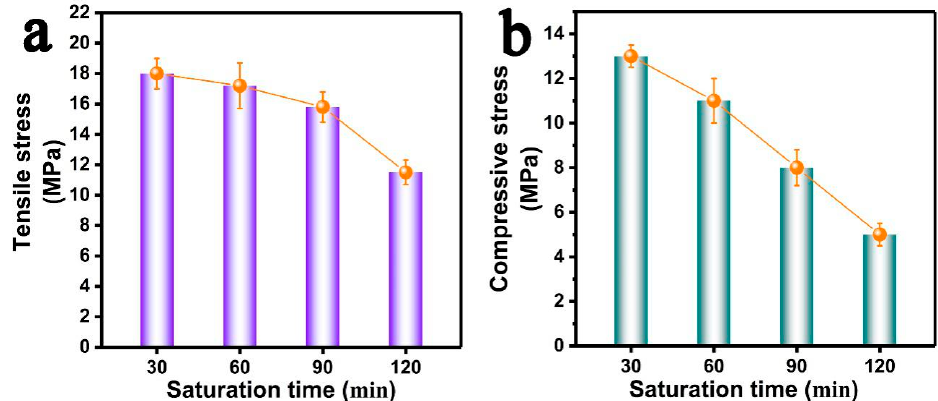
Figure 10. ( a ) Tensile stress and ( b ) compressive stress of PP/FKM foams prepared at different saturation times (30 min, 60 min, 90 min, and 120 min).